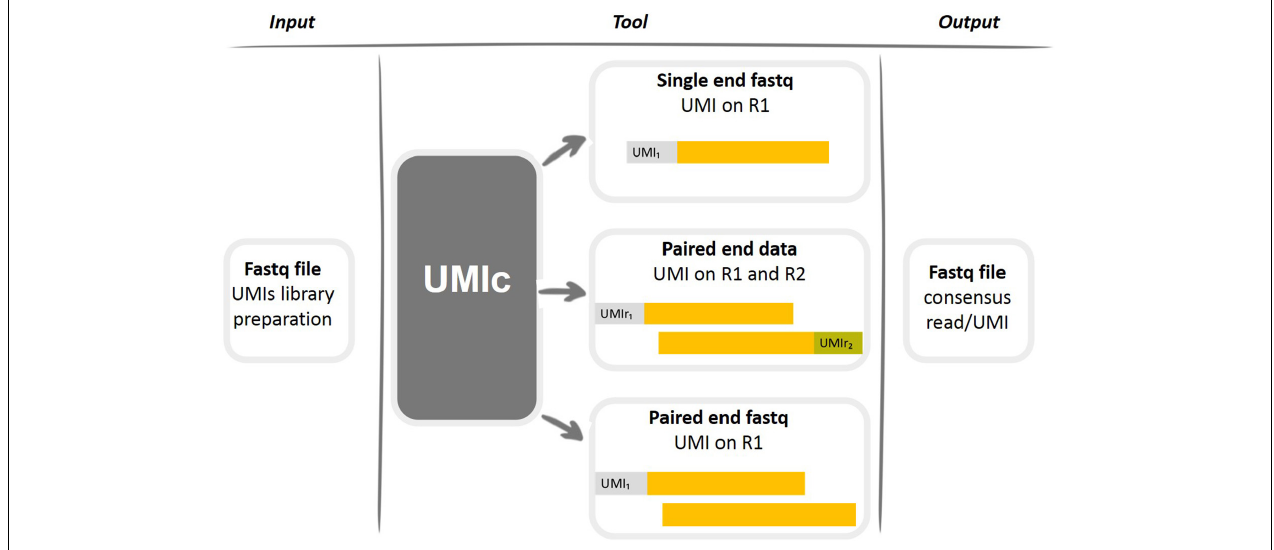
FIGURE 1 | Graphical representation of working cases of the UMIc tool.